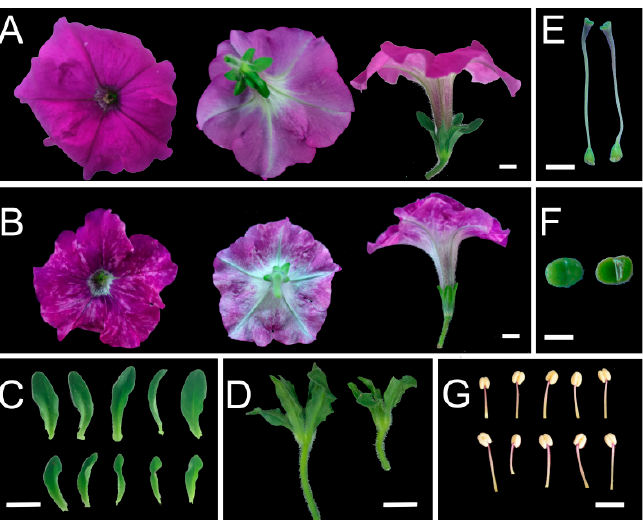
Figure 4. Effect of PhSK silencing on flowers. ( A , B ) Top view, back view, and side view of control flower ( A ) and PhSK -silenced flower ( B ). ( C ) Calyces of the control plants ( top ) and PhSK -silenced plants ( bottom ). ( D ) Sepals of the control plants ( left ) and PhSK -silenced plants ( right ). ( E ) Pistils of the control plants ( left ) and PhSK -silenced plants ( right ). ( F ) Stigmas of the control plants ( left ) and PhSK -silenced plants ( right ). ( G ) Stamens of the control plants ( top ) and PhSK -silenced plants ( bottom ). ( A – D ) Bar = 1 cm, ( E ) bar = 0.5 cm, ( F , G ) bar = 0.2 cm. pTRV2- PhSK treatment significantly reduced the PhSK mRNA level in corolla,